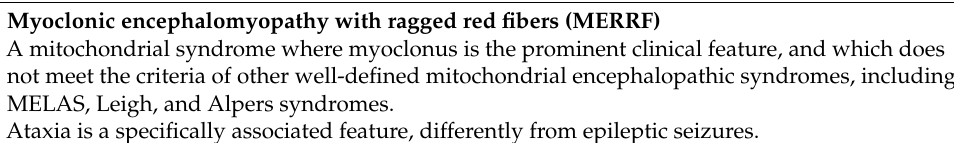
Table 3. Revisited mitochondrial syndromes. Possible definitions for some of the most typical mitochondrial